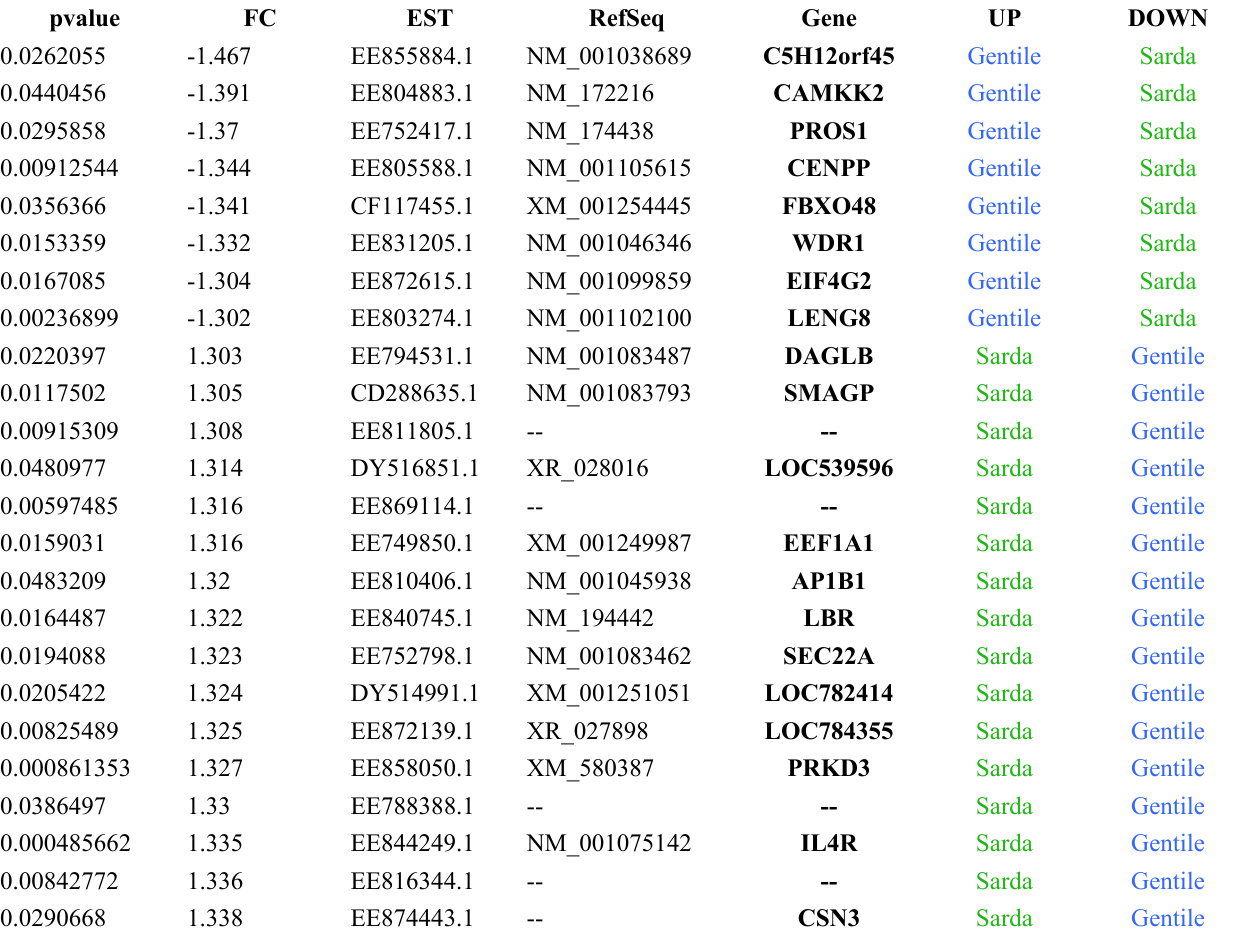
Table 3. Differentially expressed genes, stage